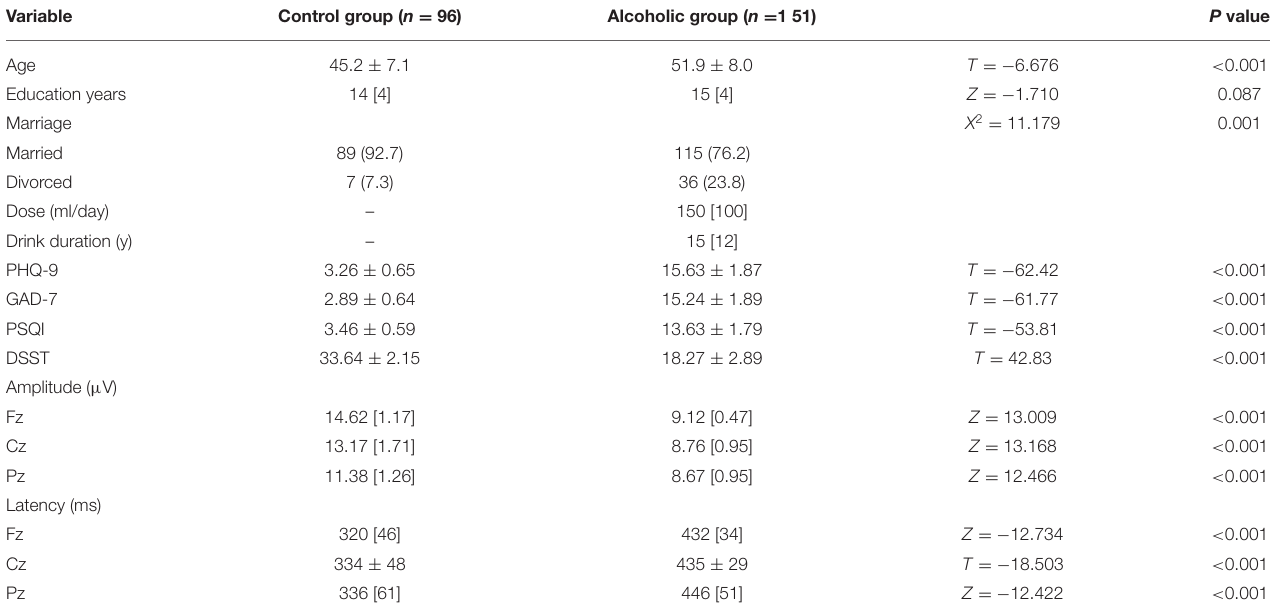
TABLE 1 | Comparison of clinical and ERP data between control group and alcoholic group. Variable